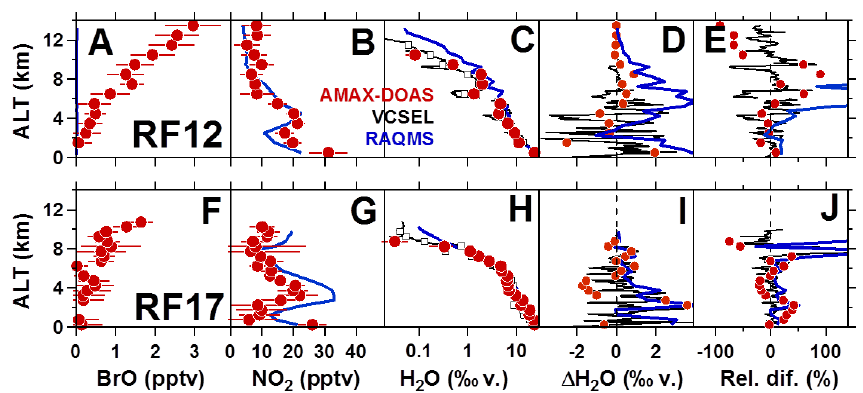
Figure 10. Vertical profiles of BrO, NO 2 and H 2 O and comparison with independent validation data in the form of in situ VCSEL-H 2 O, RAQMS-H 2 O and RAQMS-NO 2 . See Sects. 3.4, 4.2, 4.3 and 4.4 for details. Table 5. Comparison of near-surface VMR and partial VCDs for CHOCHO and IO during RF17. (cid:49) VCD + (cid:49) VCD + trop SCD a VMR + VCD a VCD a trop (cid:49) VMR + MBL MBL Ref 0 . 1 0 . 1 (moleccm − 2 ) (pptv) (moleccm − 2 ) (moleccm − 2 ) (%) (%) (%) CHOCHO SMAX 0.0 32 ± 6 0.83 ± 0.19 1.00 ± 0.21